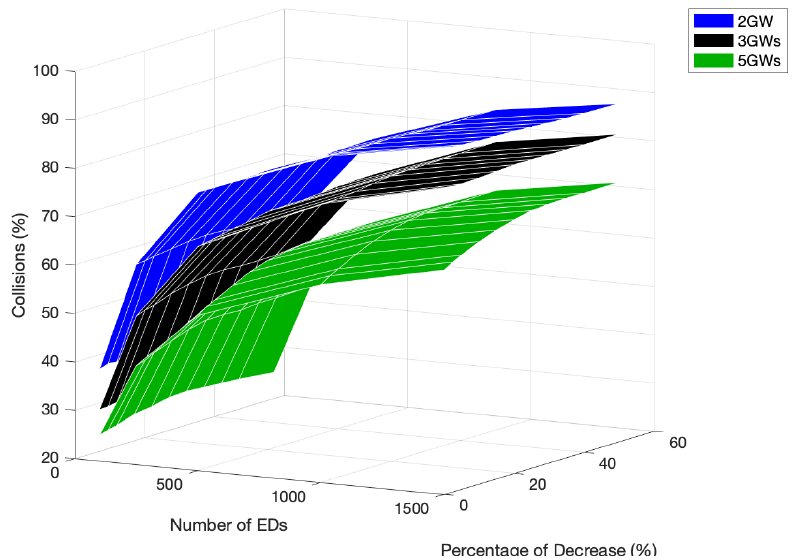
Figure 21. Percentage of collisions comparison for different numbers of GWs, network sizes, and